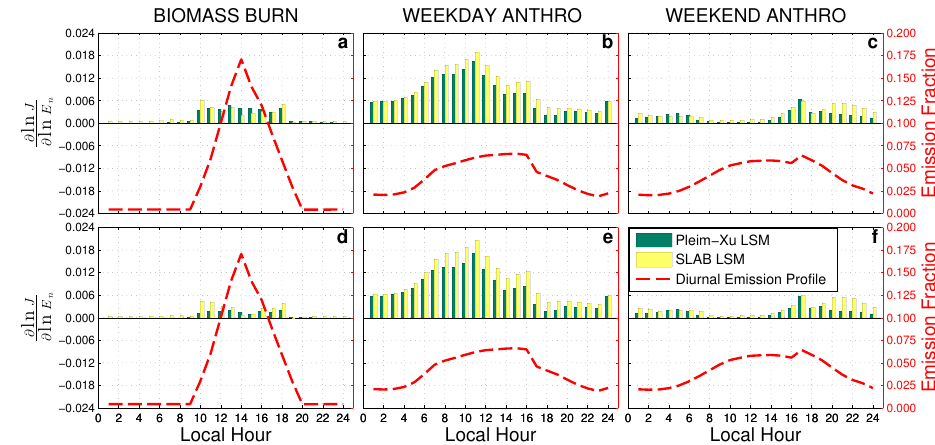
Figure 11. Diurnal normalized sensitivities ( ∂ ln J ) of the 4D-Var cost function with respect to emissions scaling factors for ( a , b , and c ) ∂ ln E n w k = 1 and ( d , e , and f ) w k from Eq. (27). Also plotted are diurnal emission fractions. Sensitivities were calculated for two different WRF LSM options and are shown separately for biomass burning, and weekend and weekday anthropogenic